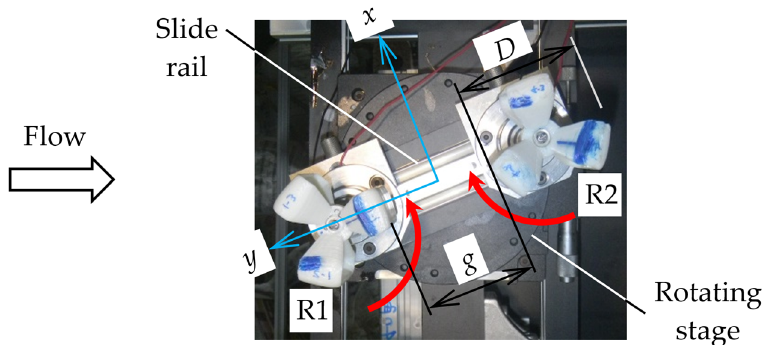
Figure 8. Setup of two VAWT models with a gap of g / D = 1 in IR configuration at θ = 112.5°.